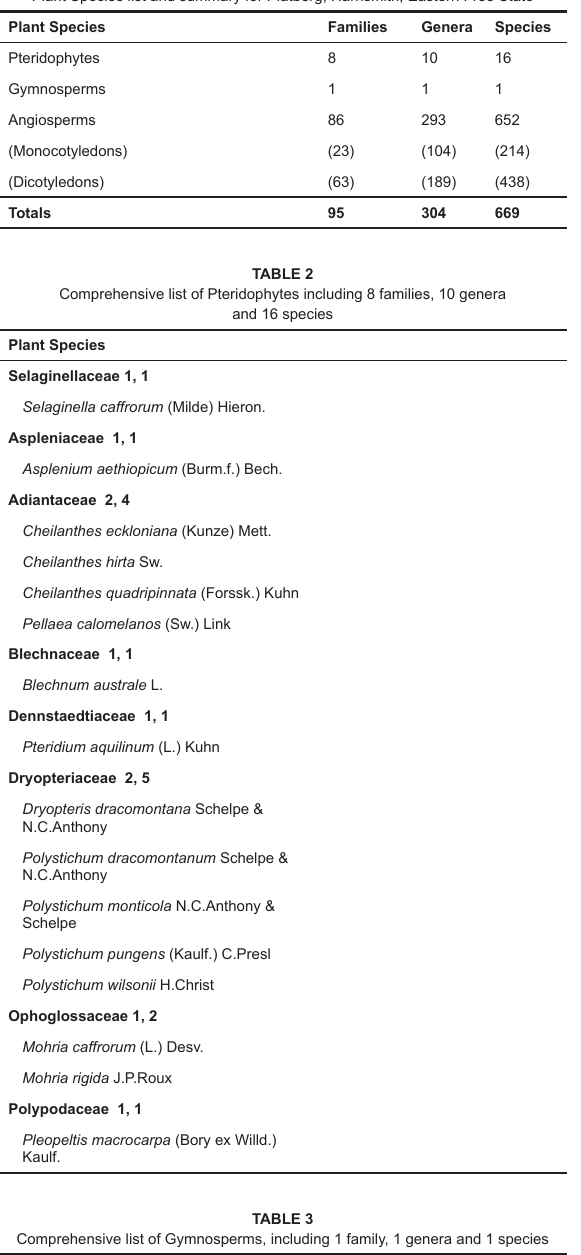
TABLE 1 Plant Species list and summary for Platberg, Harrismith, Eastern Free State